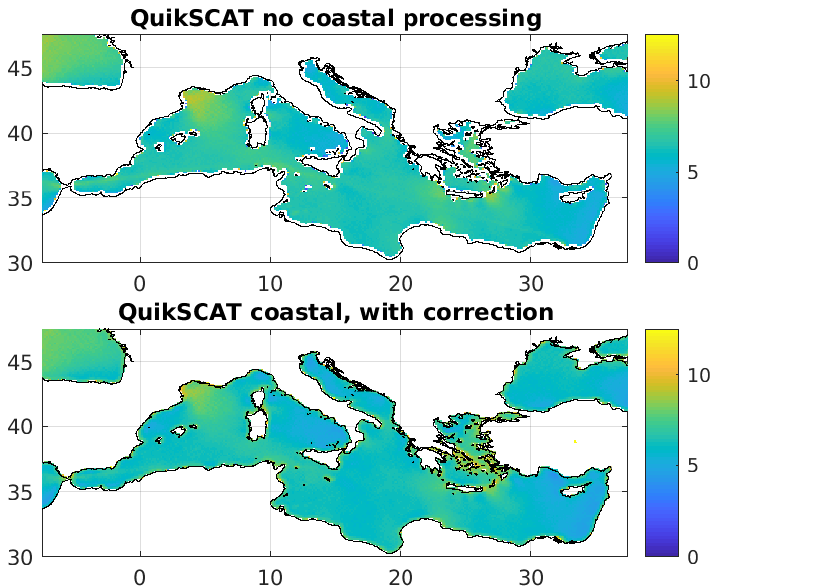
Figure 10. ( top ) One year of QuikSCAT V3 data over the Mediterranean Sea, which does not include any coastal processing or correction. ( bottom ) Same for QuikSCAT V4.1. Note the data gap around land is nearly closed, as we retrieve useable winds up to 10 km from land. Overall QuikSCAT V4.1 retrieves about 4 percent more WVCs than version 3